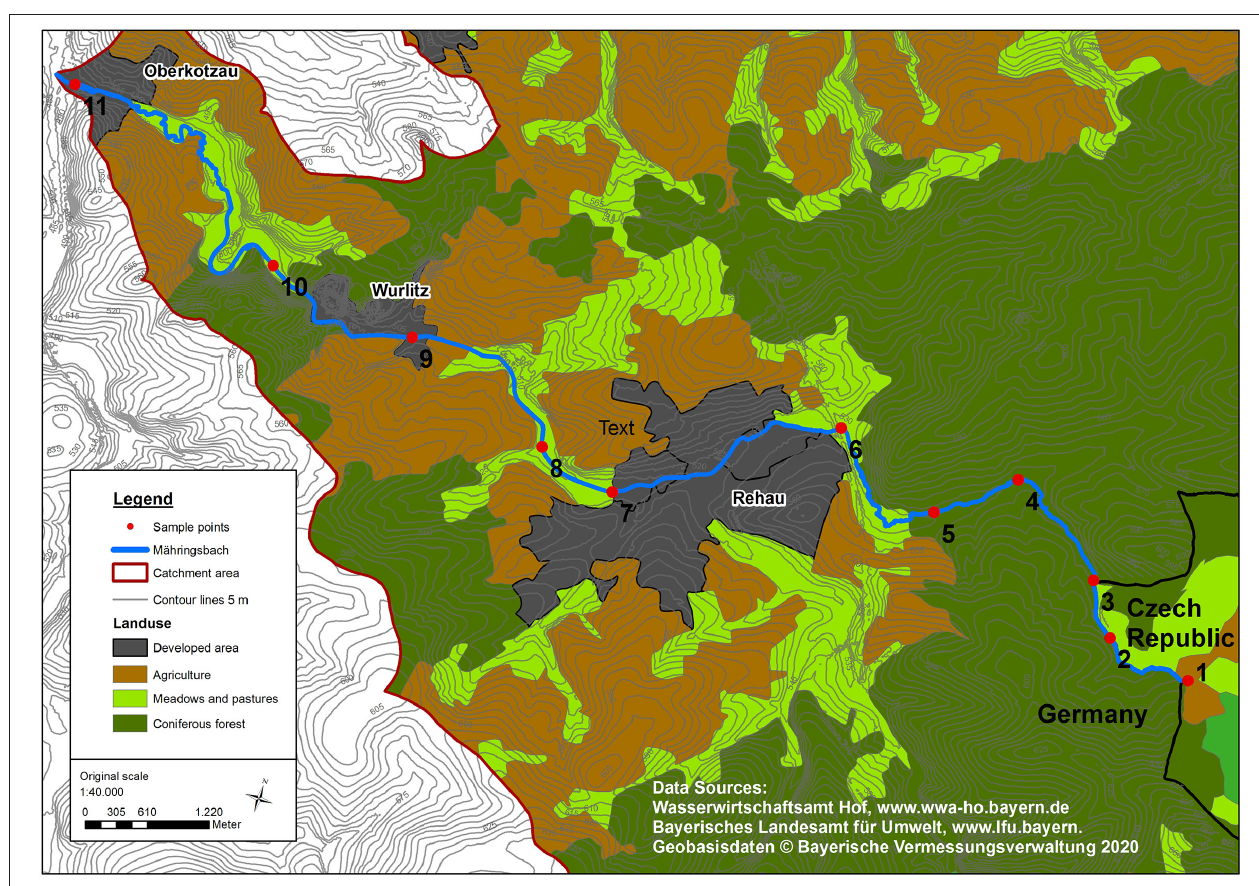
FIGURE 1 | Land-use and topographic map of the Mähringsbach catchment with sampling